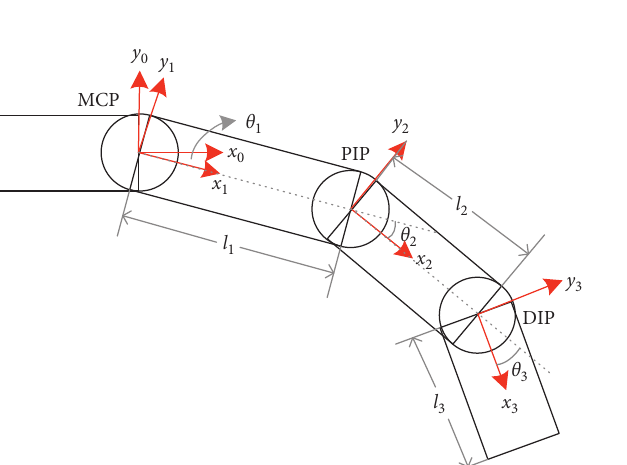
, l , l denote the length of the proximal phalanx, intermediate phalanx, and distal 1 2 3